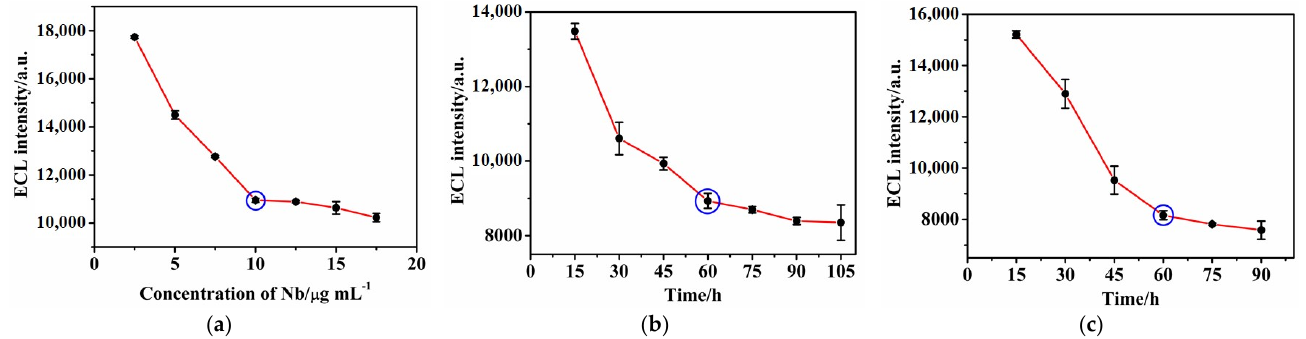
Figure 6. Effects of different parameters on performance of the fabricated ECL-RET immunosensor: ( a ) concentrations of Nb28 − C4bp α heptamer; ( b ) incubation time of Nb28 − C4bpa heptamer; ( c ) incubation time of OTA − Apt − NU − 1000(Zr) in 0.1 M PBS con- taining 20 mM K 2 S 2 O 8 and 0.1 M KCl.